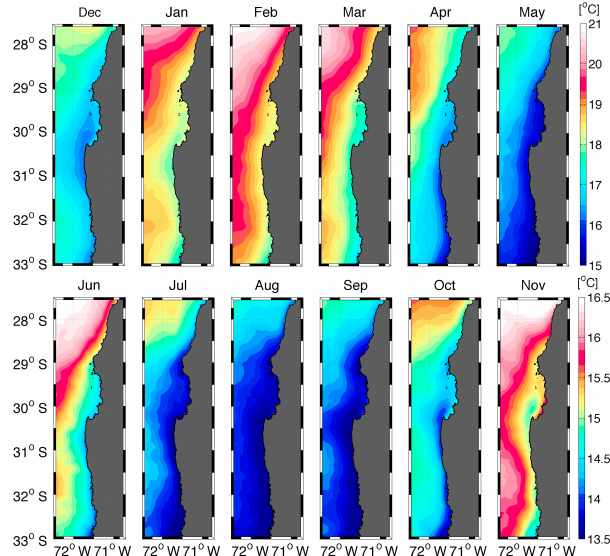
Figure 9. Annual cycle of sea surface temperature obtained using data from the Multi-scale Ultra-high Resolution (MUR). Top and bottom panels used a different color-map